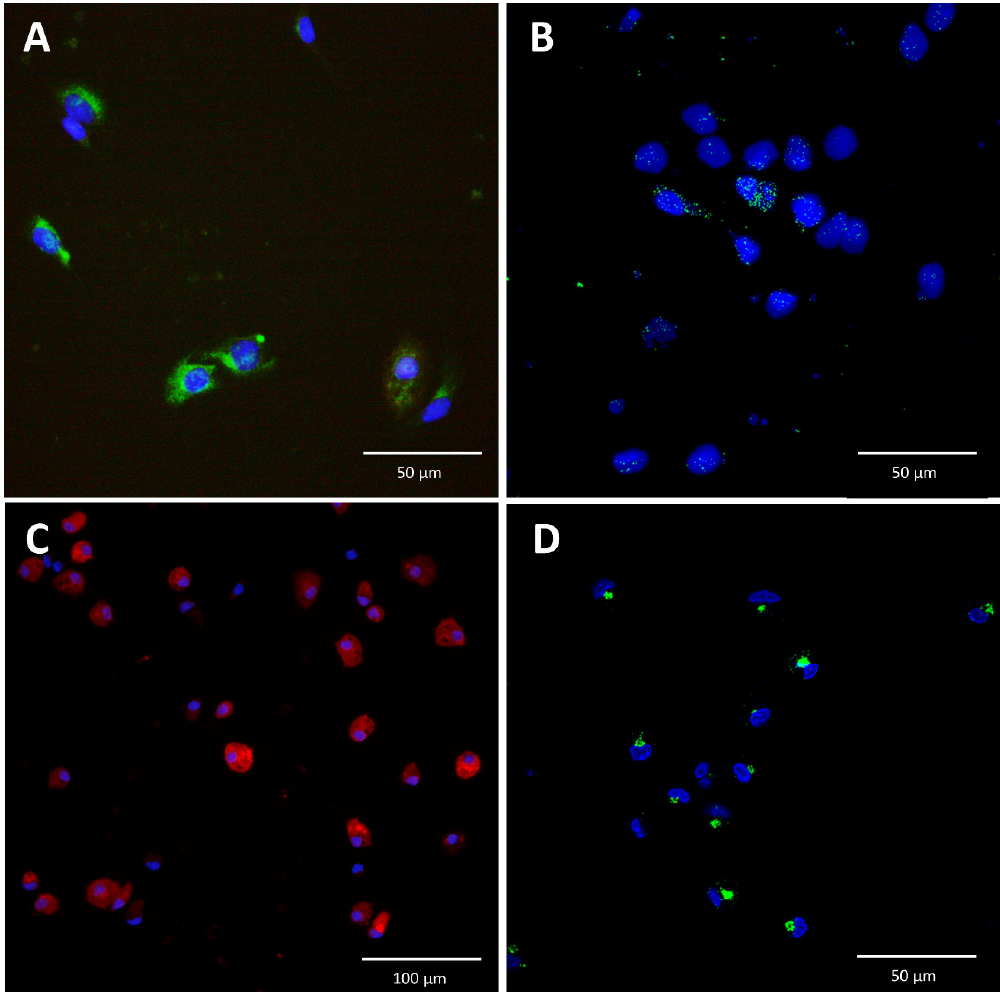
Figure 2. Immunofluorescence staining for interleukin-6 in liver sinusoidal endothelial cells and Kupffer cells. A : Isolated liver sinusoidal endothelial cells (LSEC) were stained for stabilin-2 (green), and their nuclei were stained with Hoechst (blue). B : In the absence of stimulation, IL-6 was not detected in LSEC (not shown). In contrast, after incubation of LSEC with APR, IL-6 (green) was detected in vesicles, with a homogeneous distribution in the cytoplasm. C : Isolated Kupffer cells (KC) were stained for IBA-1 (red) and their nuclei were stained with Hoechst (blue). D : KC were stimulated with lipopolysaccharide (0.5 mg/mL) and exhibited a different cytoplasmic distribution of IL-6 than LSEC. In LSEC, IL-6 was more homogeneously distributed in the cytoplasm ( B ) around the nuclei, whereas in KC, IL-6 appeared in clustered vesicles ( D ). 3.2. Platelet-Derived Extracellular Vesicles Are Not Implicated in Interleukin-6 Secretion by Liver Sinusoidal Endothelial Cells Extracellular vesicles (EV) can vehicle molecules, including proteins. To analyze whether supernatants of mouse APR, depleted from platelet PMP, remain active and stimulate LSEC IL-6 secretion, we selectively removed PMP by differential centrifugation. After centrifugation, mouse APR supernatant containing proteins and exosomes still increased IL-6 secretion by LSEC and was similar to the control conditions (Figure S2A). Moreover, using PMP prepared from TRAP-6 human APR or derived from human platelet submitted to freeze-thawing, an increase of IL-6 production by LSEC was not observed (Figure S2B,C). PMP preparations were qualitatively assessed with flow